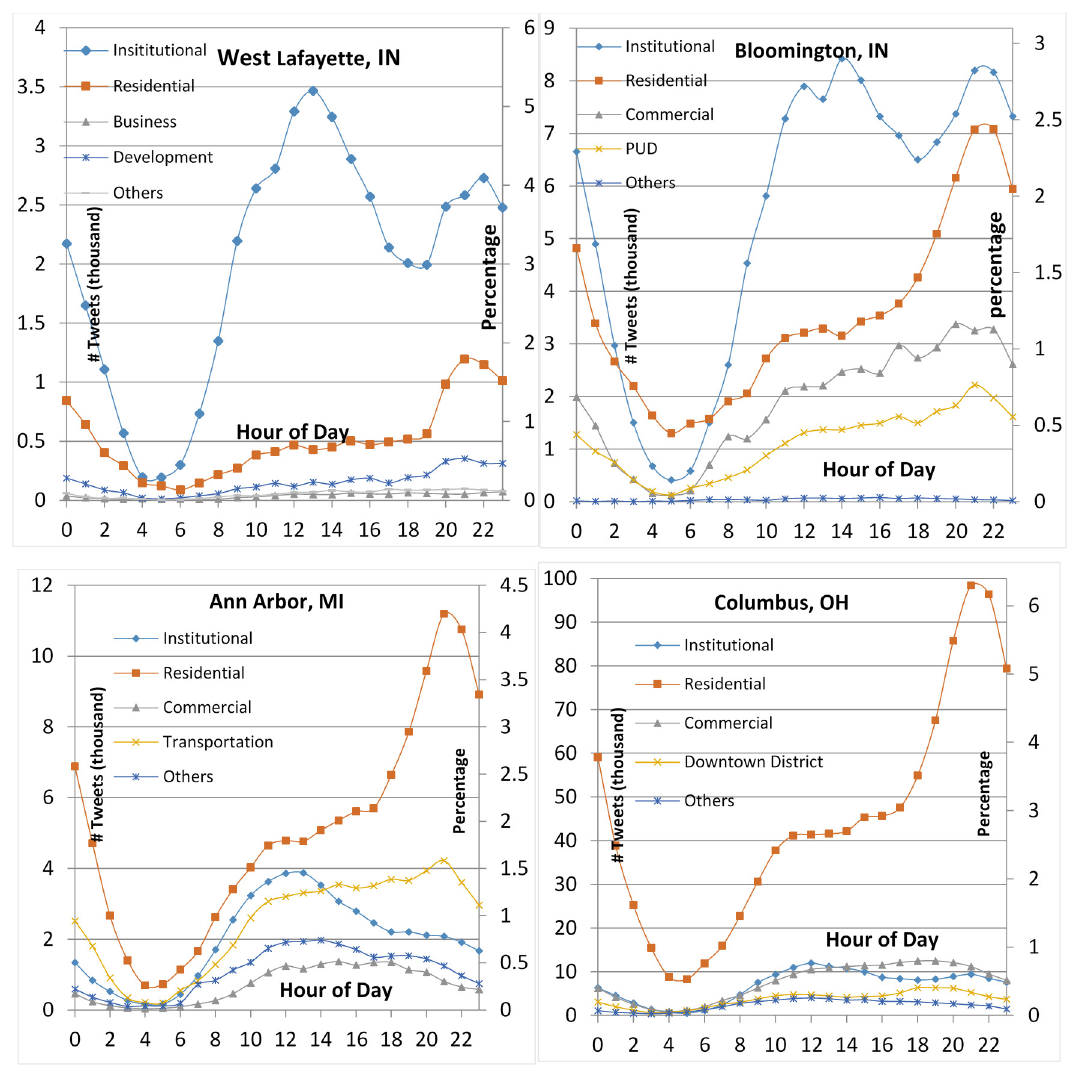
Figure 4. Distribution of number (in count and percentage) of hourly tweets in terms of land use.